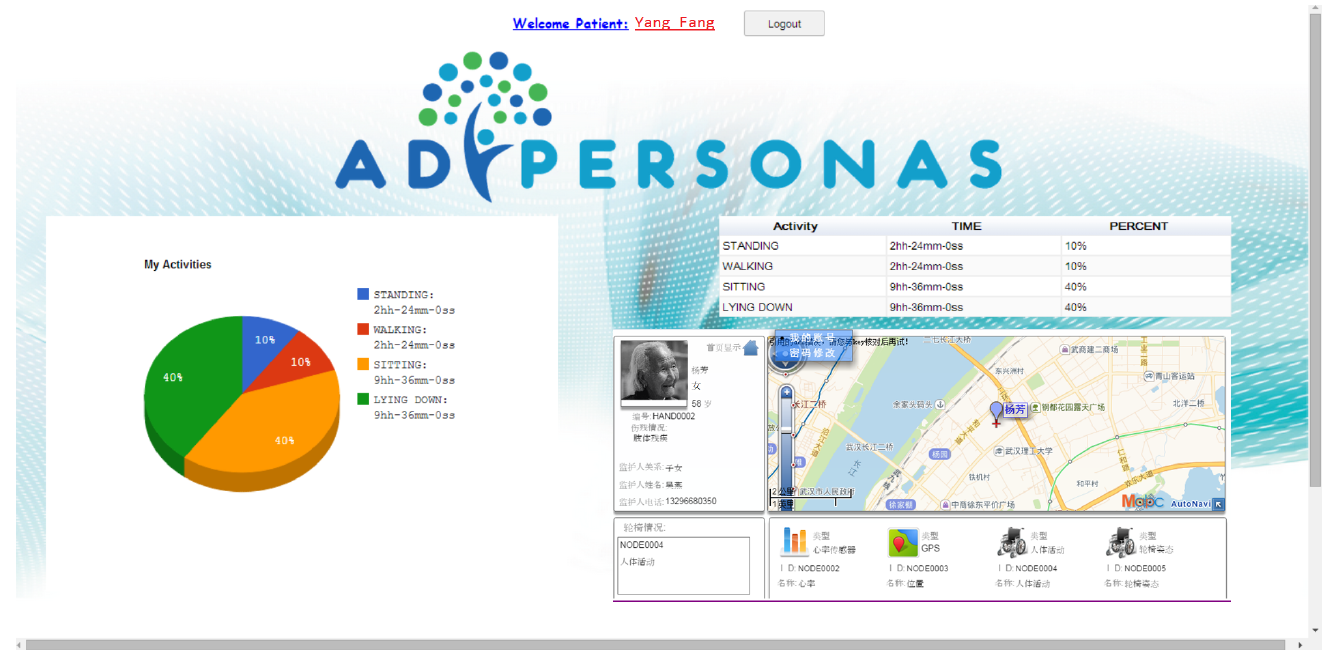
Fig. 1. The main dashboard of the Activity-aaService web-app module.